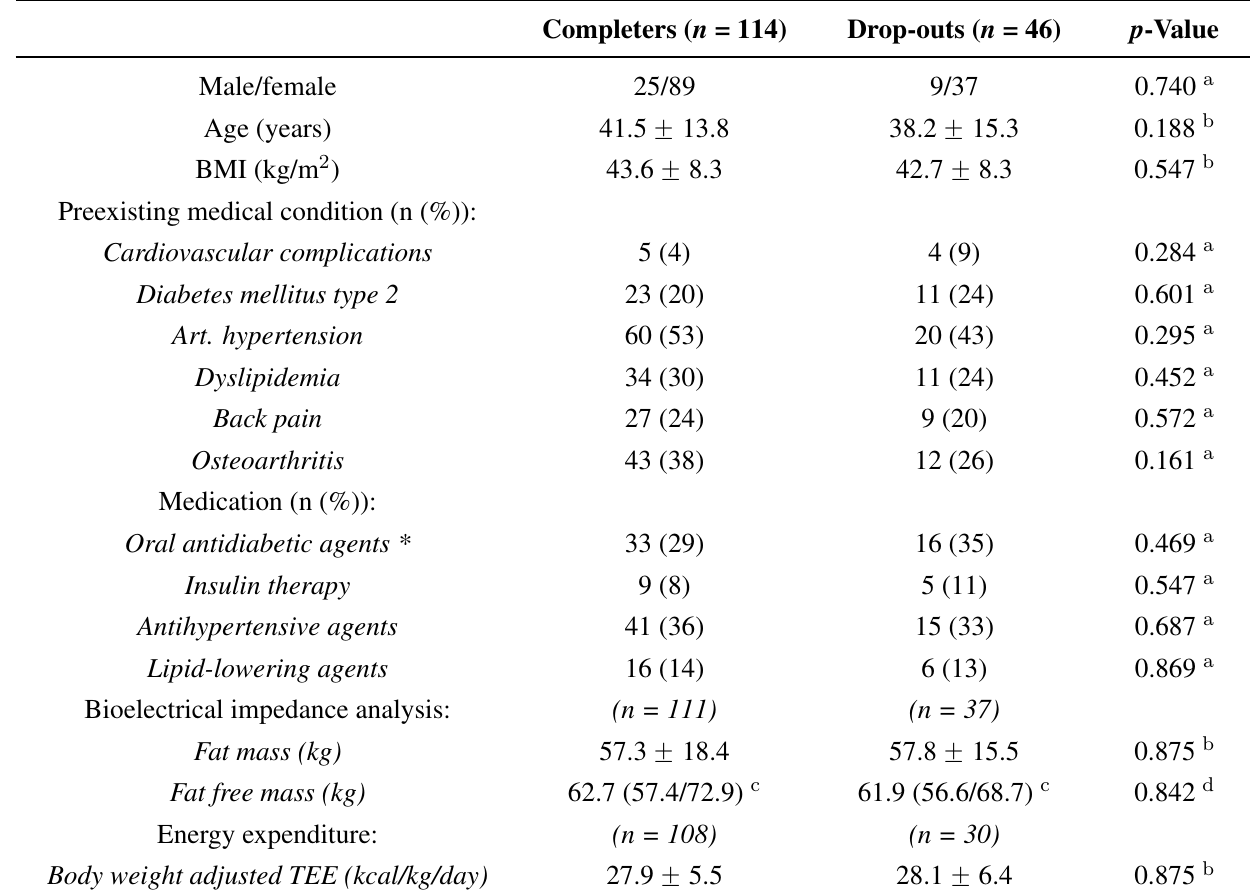
Table 2. Subject data, bioelectrical impedance analysis, energy expenditure and pattern of physical activity at baseline according to